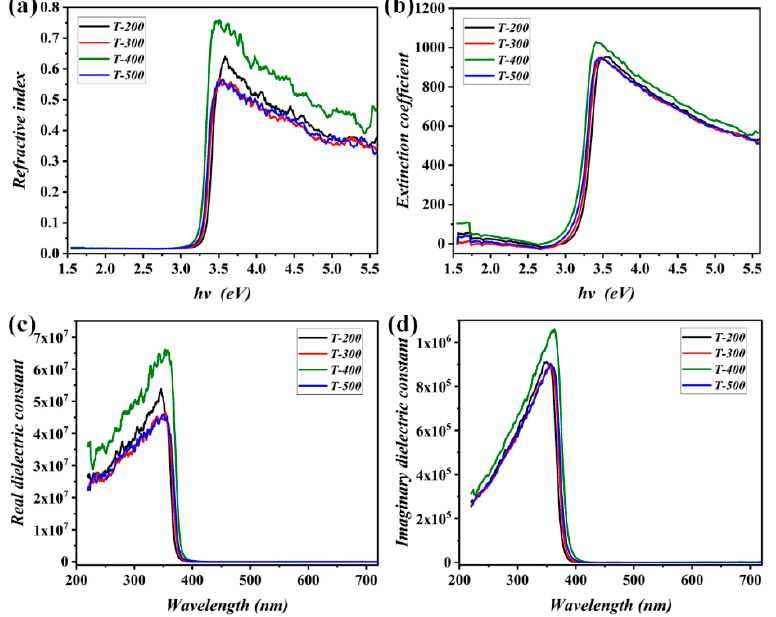
Figure 7. Variation of ( a ) refractive index, ( b ) extinction coefficient, ( c ) real, and ( d ) imaginary dielectric constant of the deposited film at different calcination temperatures.